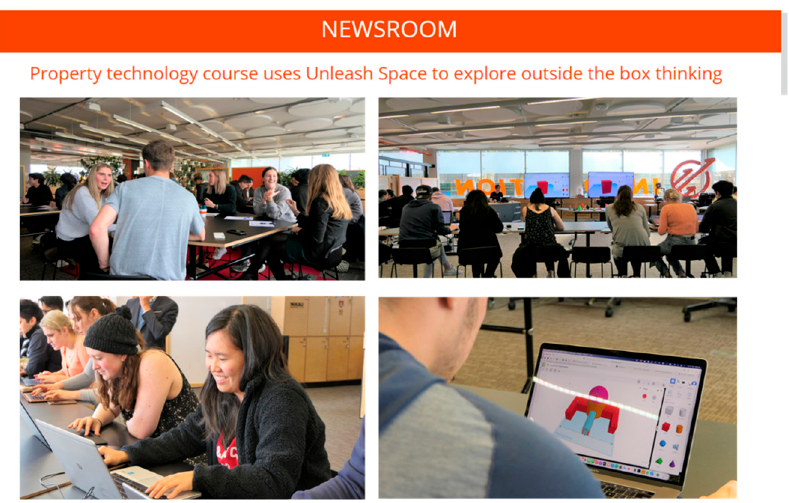
Figure 2. The property technology course uses Unleash Space to explore outside-the-box thinking.